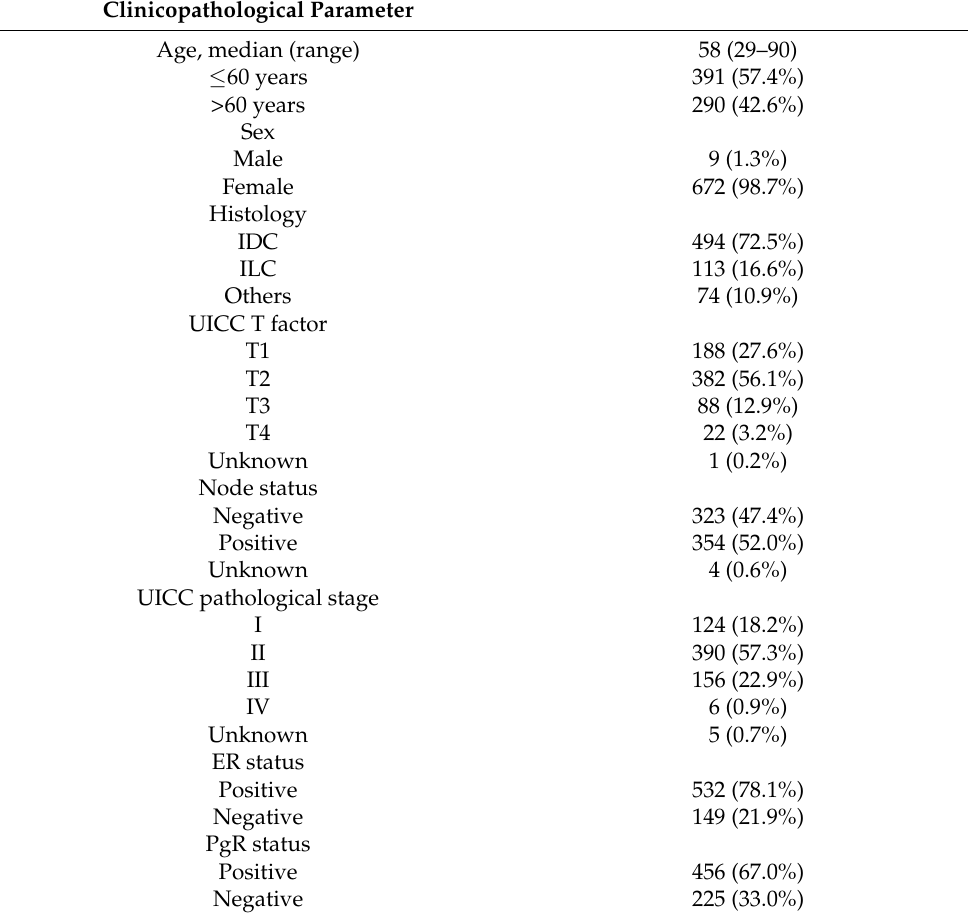
Table 4. Clinicopathological characteristics of 681 patients in the TCGA